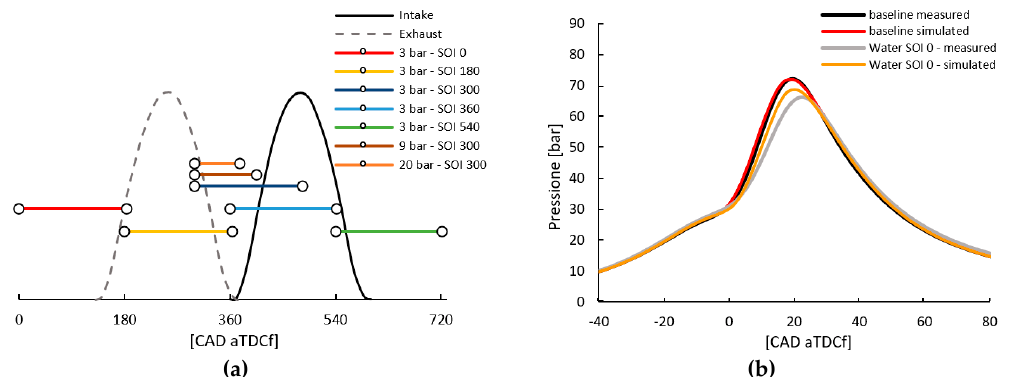
Figure 6. Timing and duration of each water injection case ( a ), and comparison of measured vs. simulated in-cylinder pressure ( b ).